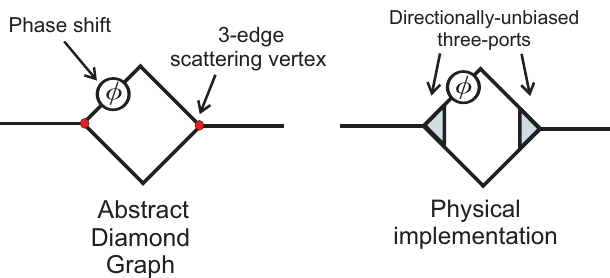
The diamond graph ( left ), consisting of two three-edge scattering vertices and a phase shift, has been used theoretically to implement scattering-based quantum walks [51–53]. Two directionally-unbiased three-ports connected to each other on two edges, with a phase shift between them provides a means to experimentally implement this graph ( right